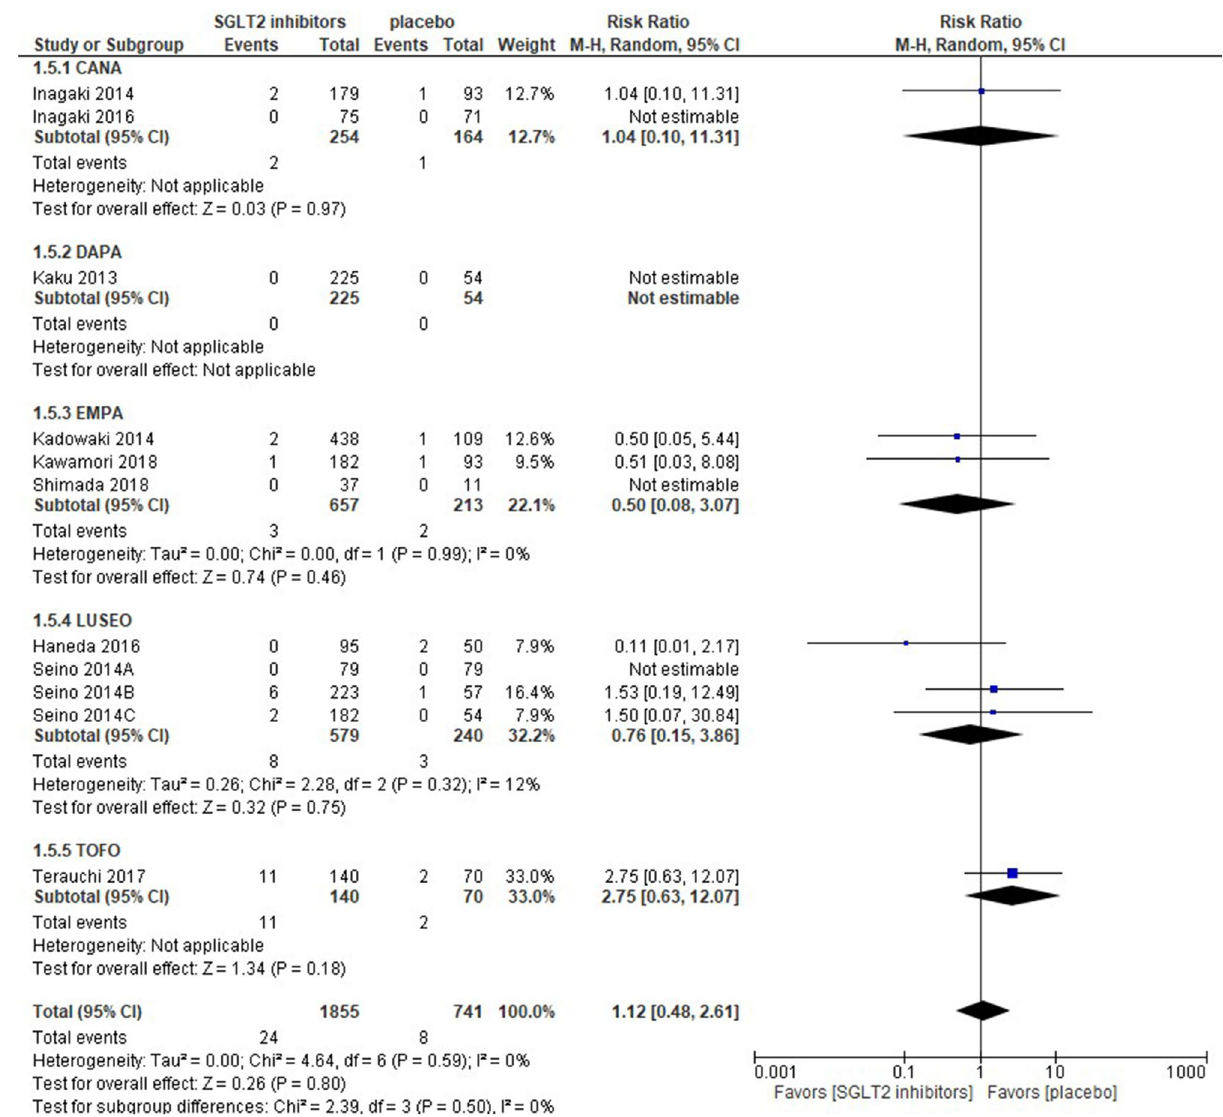
Figure 4. Forest plot for the risk of hypovolemia. CANA canagliflozin, DAPA dapagliflozin, EMPA empagliflozin, LUSEO luseogliflozin, TOFO tofogliflozin, SGLT2 sodium-glucose co-transporter